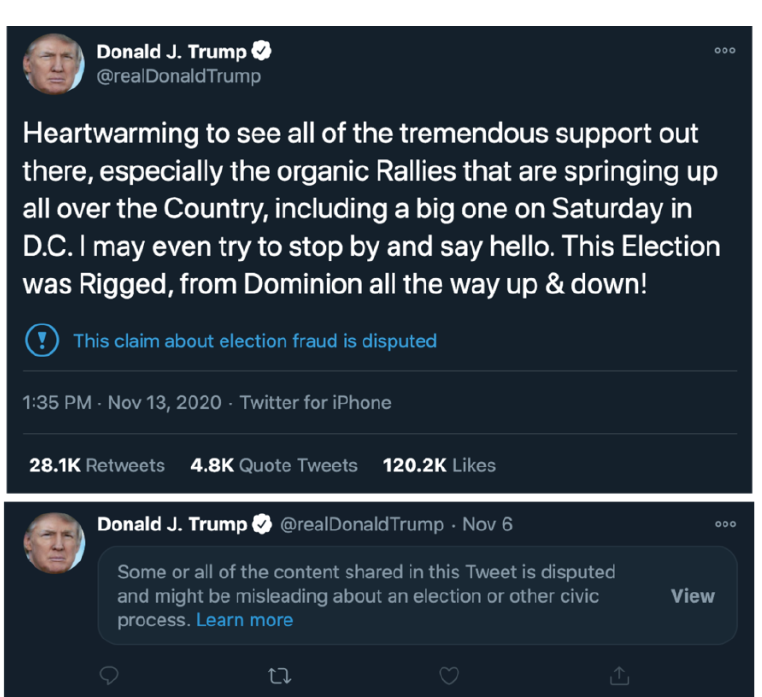
Figure 1. Examples of a “soft intervention” (top) and “hard intervention” (bottom) on